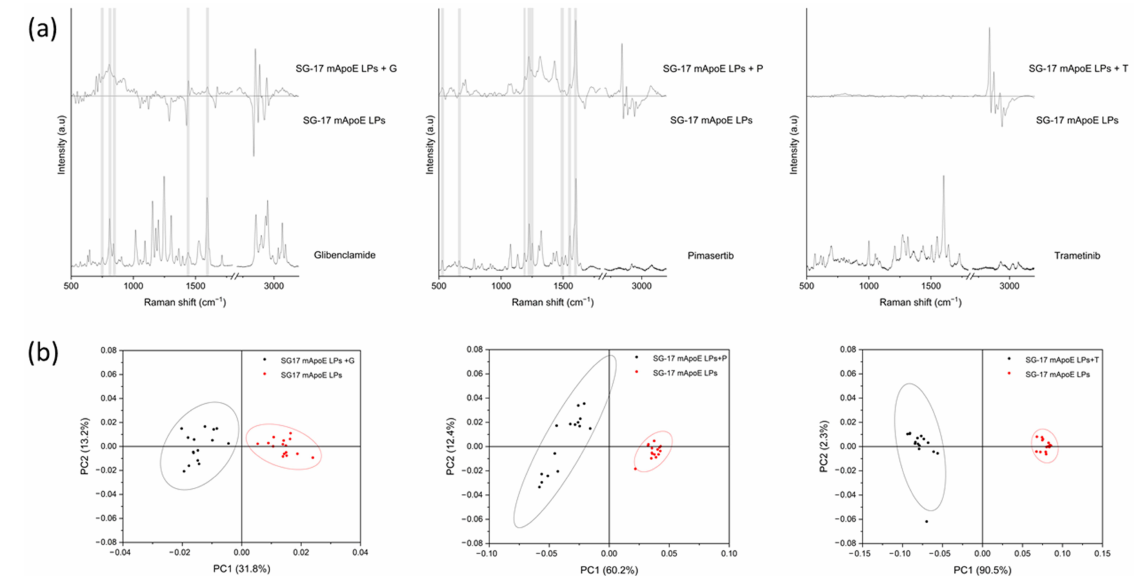
Figure 5. ( a ) Comparison between the subtraction spectrum of three formulations and the spectrum of the relative drugs. The grey bands identify the common peaks; ( b ) results of the PCA performed on SG-17 mApoE LPs loaded (black) and unloaded (red) with three drugs. The ellipses represent the 95% confidence interval; each dot represents one spectrum.